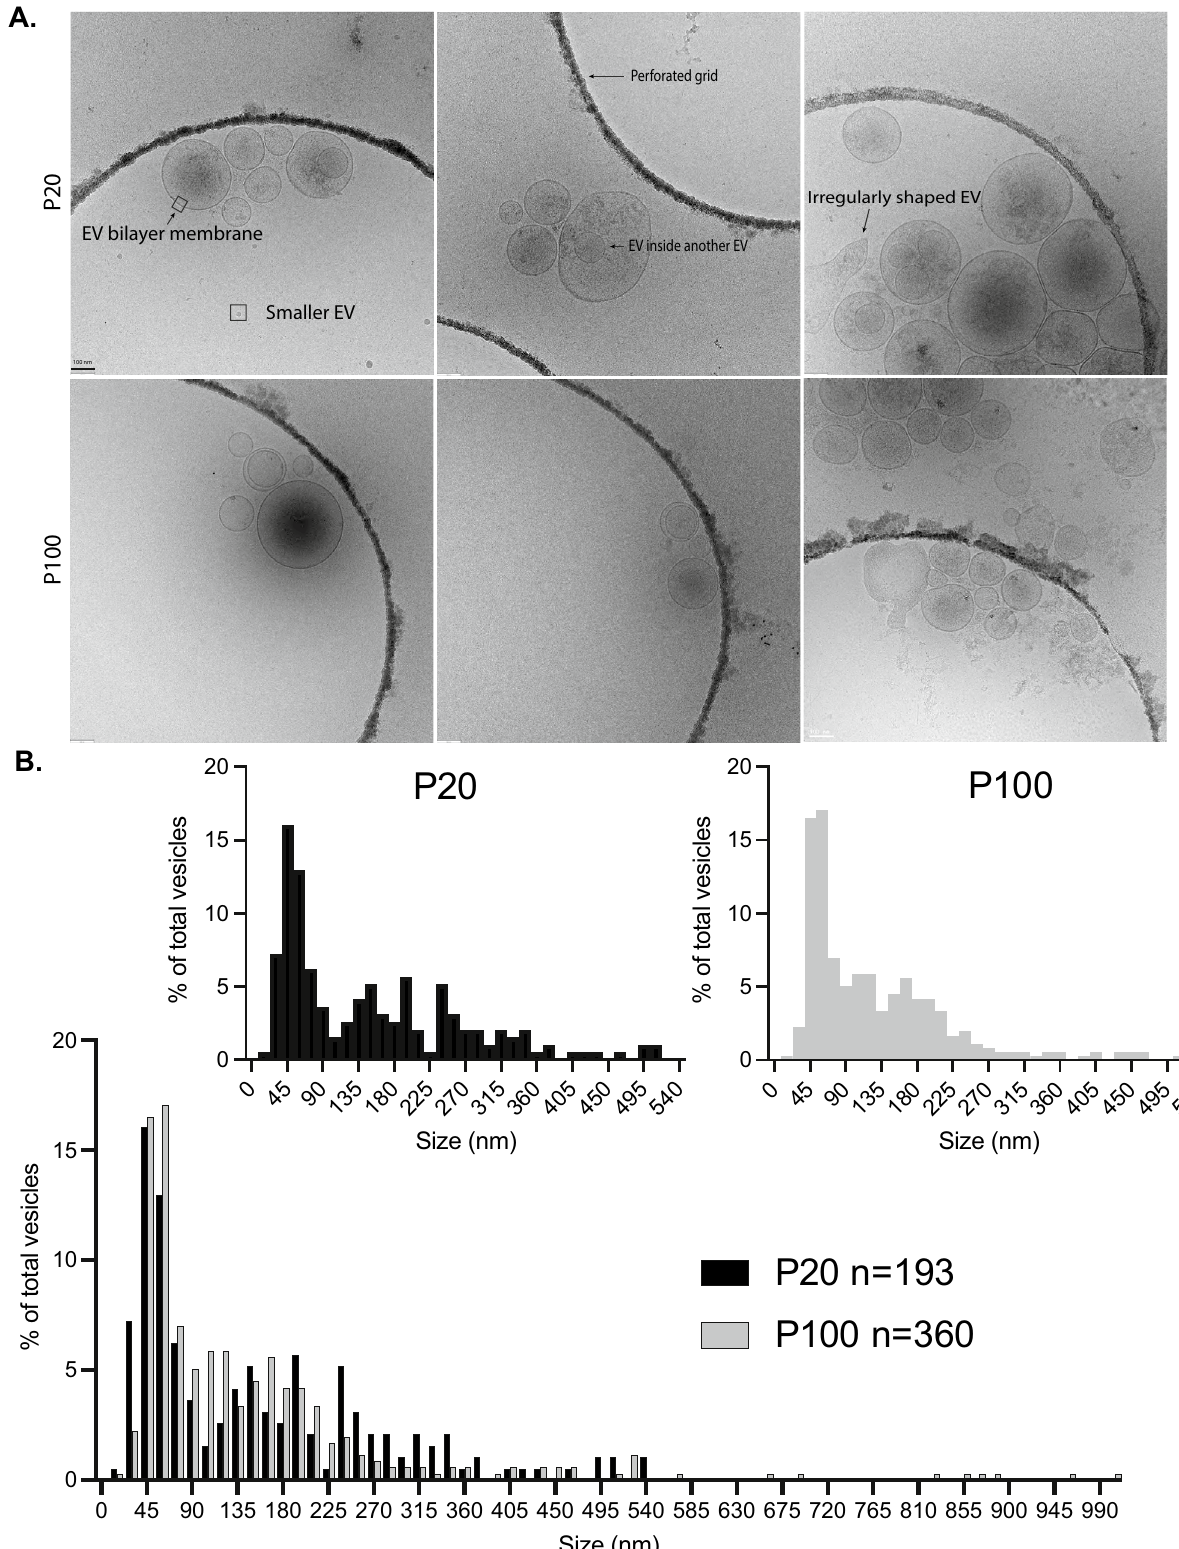
Figure 2. Morphology and sizing of EVs by cryo-EM. ( A ) Cryo-EM micrographs from the P20 (top row) and P100 (bottom row) fractions. Different types of EVs are annotated for easier appreciation of diverse EV morphologies. ( B ) Size distribution histogram for all measured EVs from cryo-EM micrographs (P20: n = 193 EVs, mean diameter 146.62 nm; P100: n = 360 EVs, mean diameter 152.59 nm). The left histogram (black bars) is the sizing of the P20 fraction, and the right histogram (gray bars) is the sizing of the P100 fraction separated out from the histogram below. Data is from three biological replicates and the scale bar is 100 nm for all